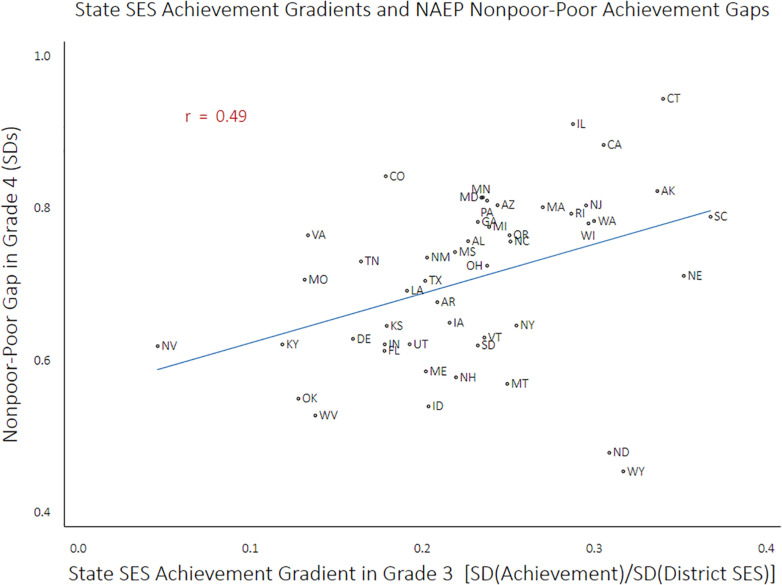
Socioeconomic status (SES) achievement gradients compared with student-level nonpoor–poor achievement gapsNote. Nonpoor–poor gap is the gap between non–free lunch eligible and free lunch eligible students, as measured using NAEP data. The correlation is disattenuated to account for measurement error in both measures.